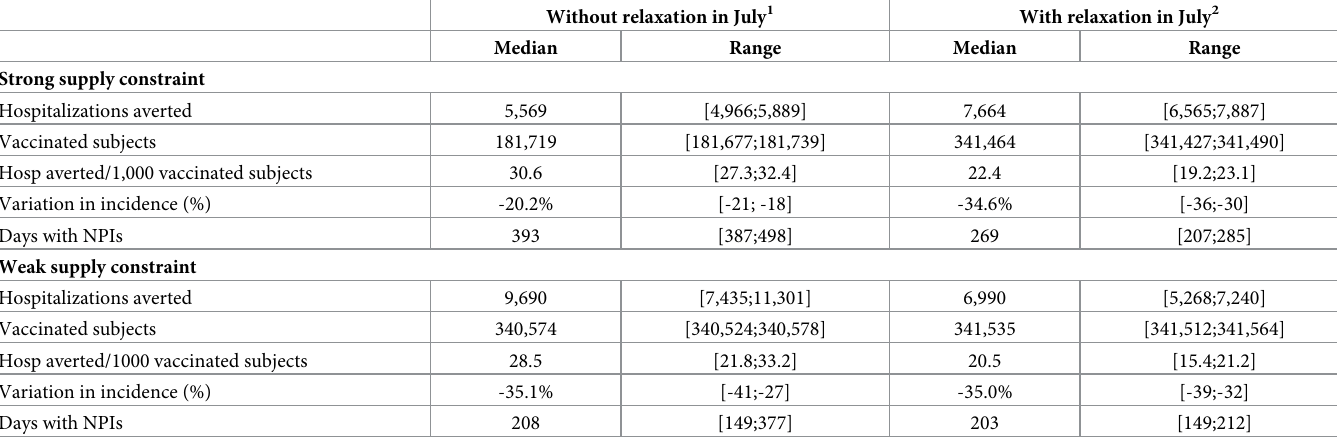
Table 3. Number of COVID-19 hospitalizations averted with and without relaxation of constraints in July 2021,